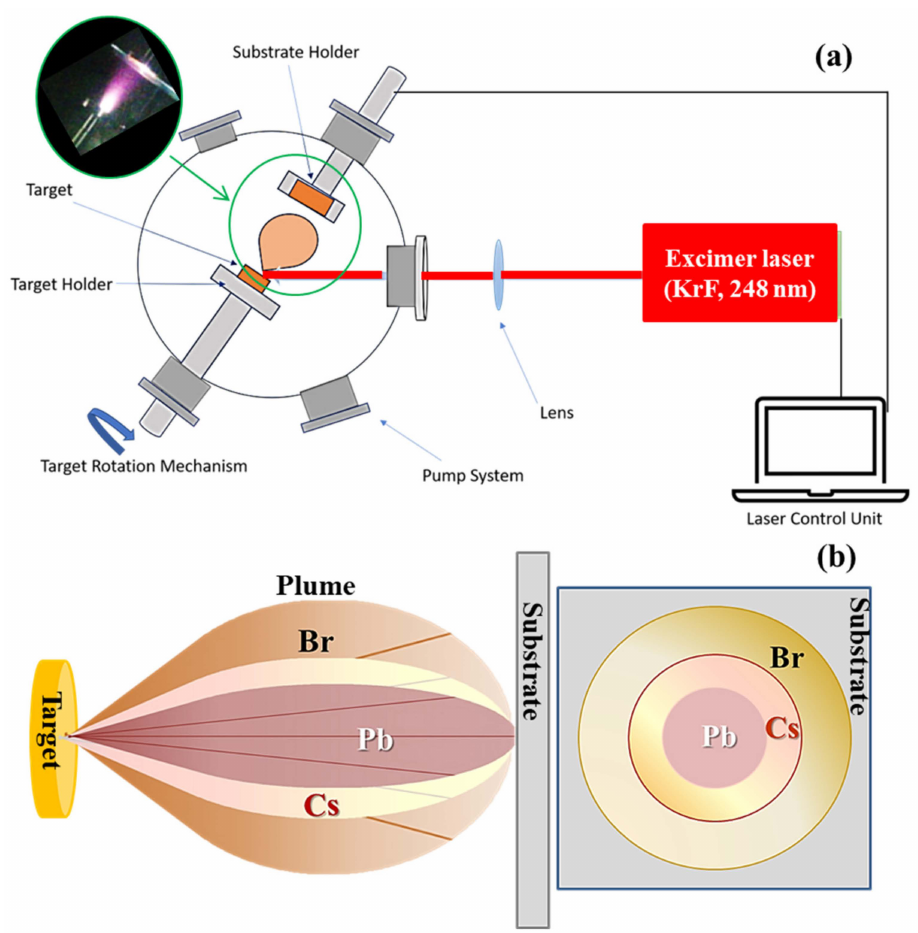
Figure 1. ( a ) Schematic diagram of a PLD experimental set-up. ( b ) Schematics of the angular and mass distribution of light and heavy species (Br, Cs and Pb) in the plasma plume generated under laser ablation of a CsPbBr 3 target. The left and right panels show a side view and the cross-sectional view of the trace over the substrate, respectively, of the plasma plume formed by ablation of a CsPbBr3